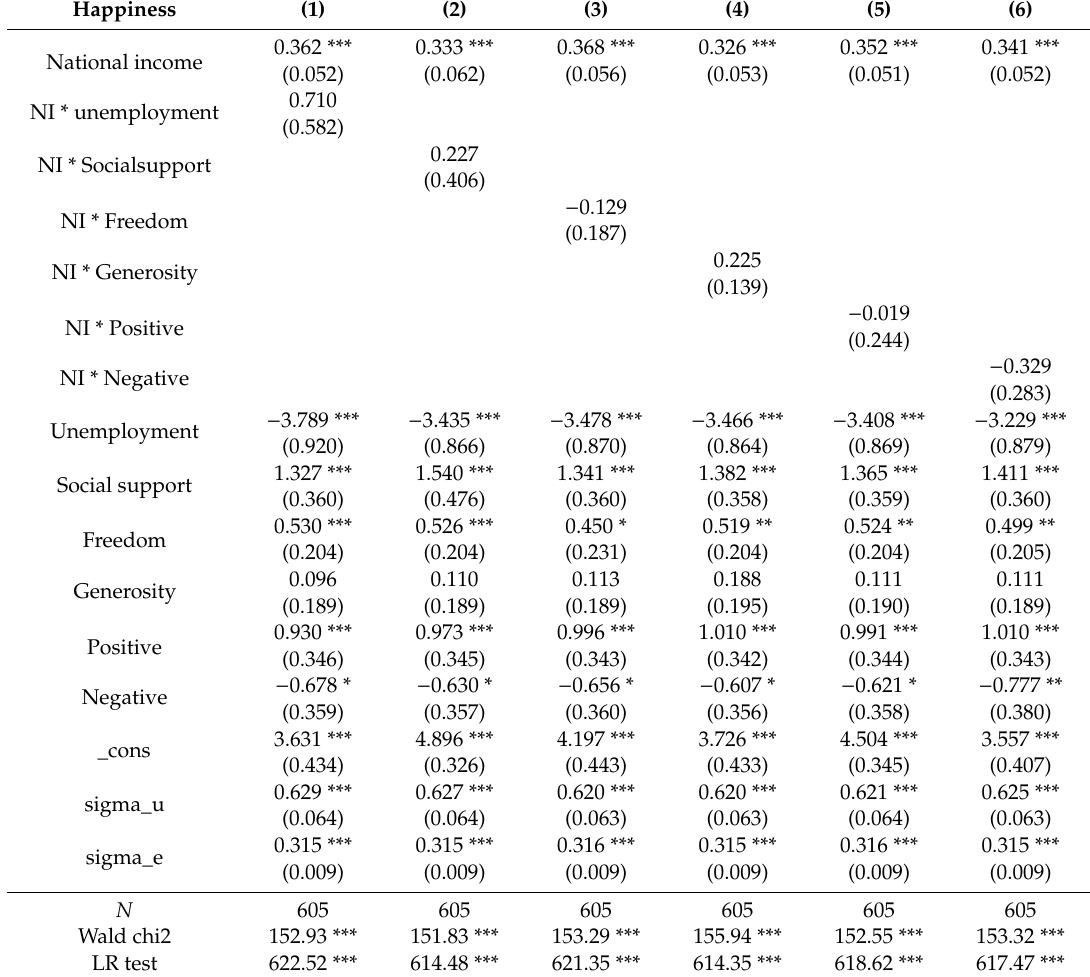
Table 8. The moderating e ff ect between national income and